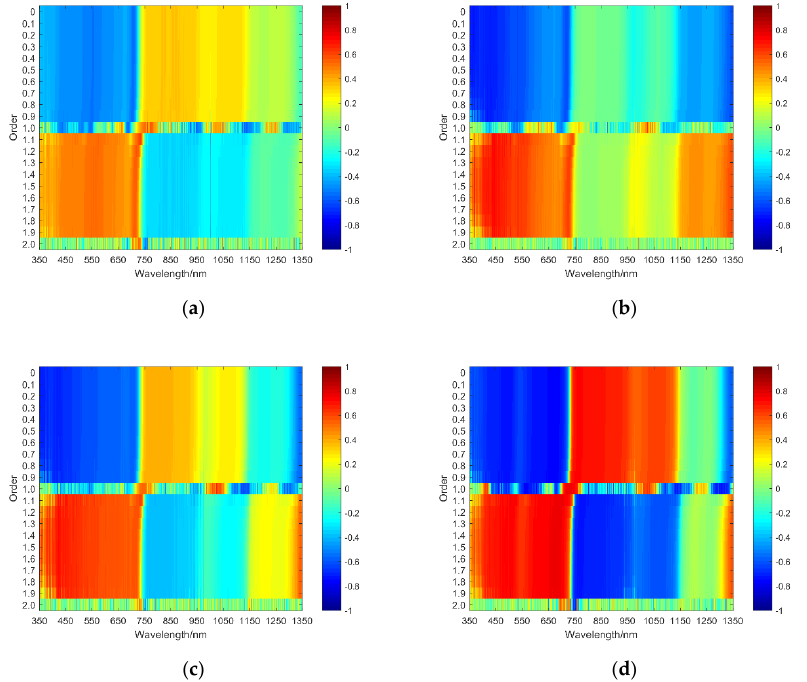
Figure 3. The relevance between the spectra of different growth periods and LWC. ( a ) Jointing period; ( b ) booting period; ( c ) flowering period; ( d ) filling period.